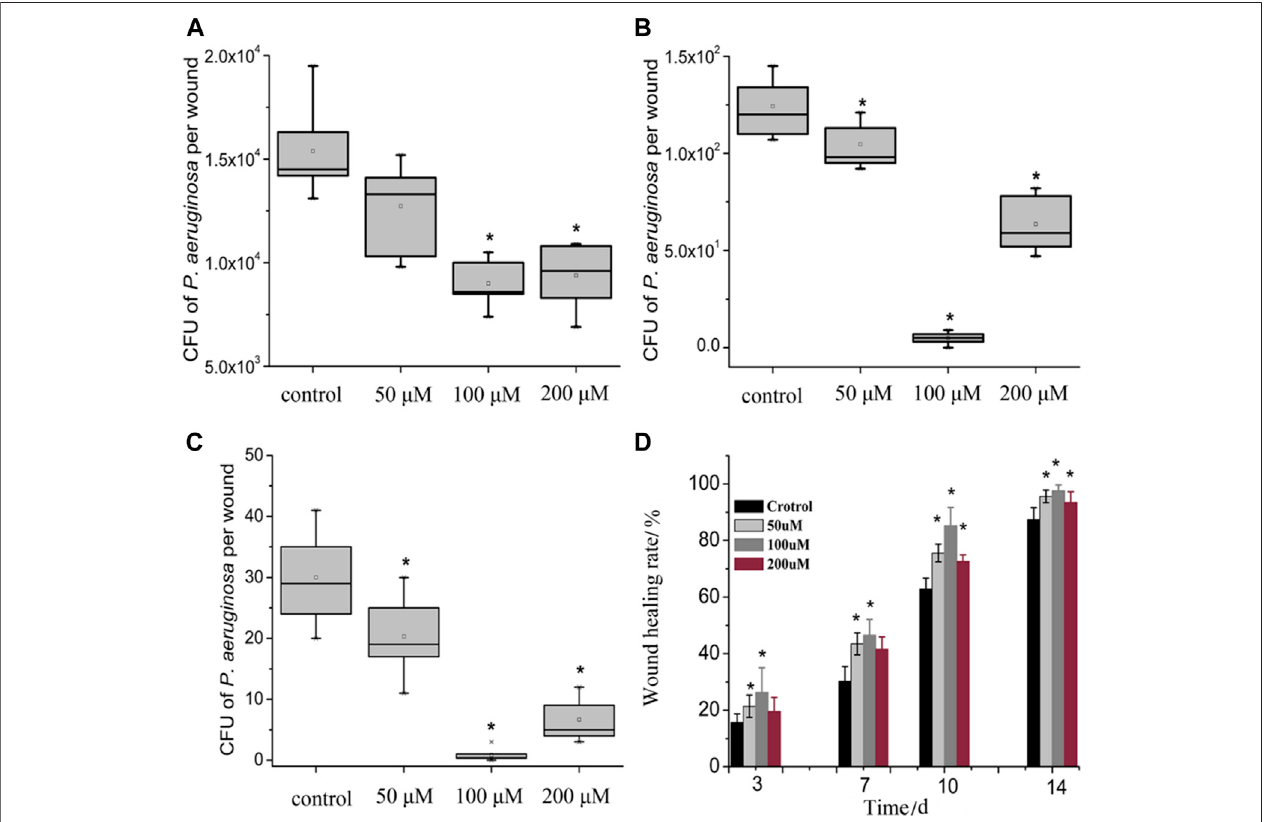
FIGURE 9 | Box plot of the viability of bacteria in wounded tissue in. Wound healing rate in the PACT chemotherapy groups when compared control groups on evaluatedatdifferentdays. (A – C) showedtherewasadose-dependentreductionoftheCFUrecoveredfromthewoundsinvarioustreatmentgroupswhencomparedto the control. Treatment groups receiving 100 µM showed the best antimicrobial activity. (D) showed that the healing percentage correlated to the reduction of CFUs illustrated in (A – C) . A reduction in CFU recovered was accompanied by an increase in wound healing percentage. Reproduced with permission from Zhao et al.